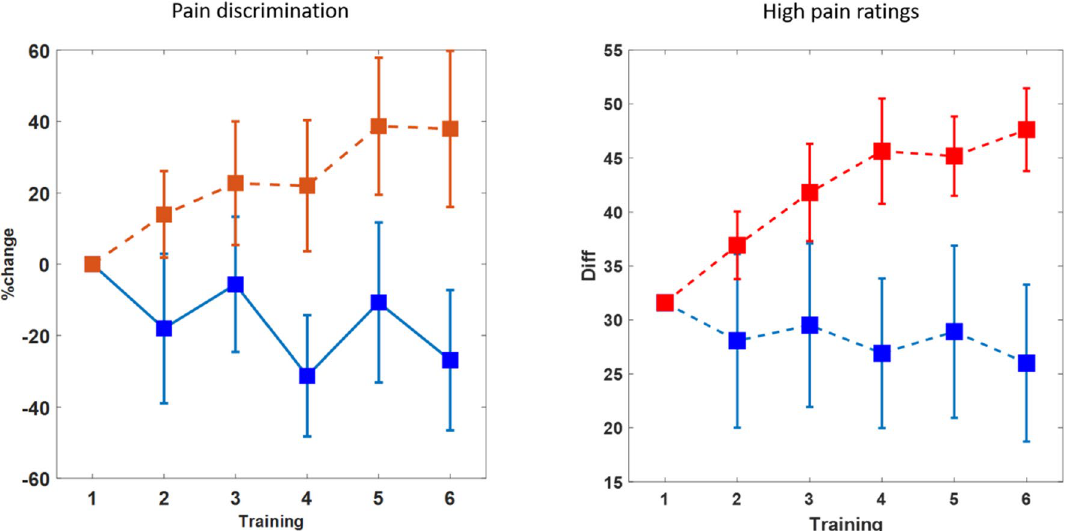
Figure 2. Pain ratings for each training day were assessed at six different intensities in the pre-training period. The discrimination between the different intensities was estimated as the distance of the ratings and reflects the modulation of the sensitivity of the pain system (left). The increasing sensitivity in the up-training group and the decreasing sensitivity of the down-training group is also reflected in the ratings for the higher painful stimuli (right, here the difference to the minimum rating is shown). Error bars depict ± 1 standard error of the mean (SEM, n = 10 in every